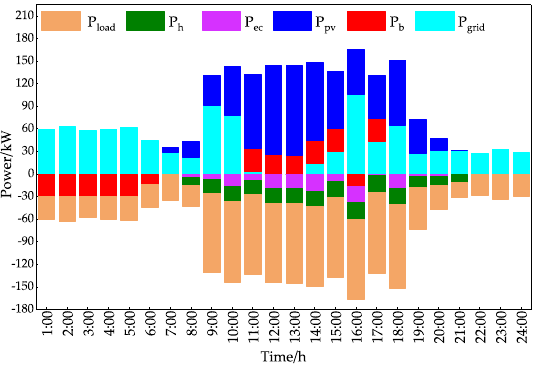
Figure 8. The optimal scheduling results when only air conditioner-based VES (ACVES) is